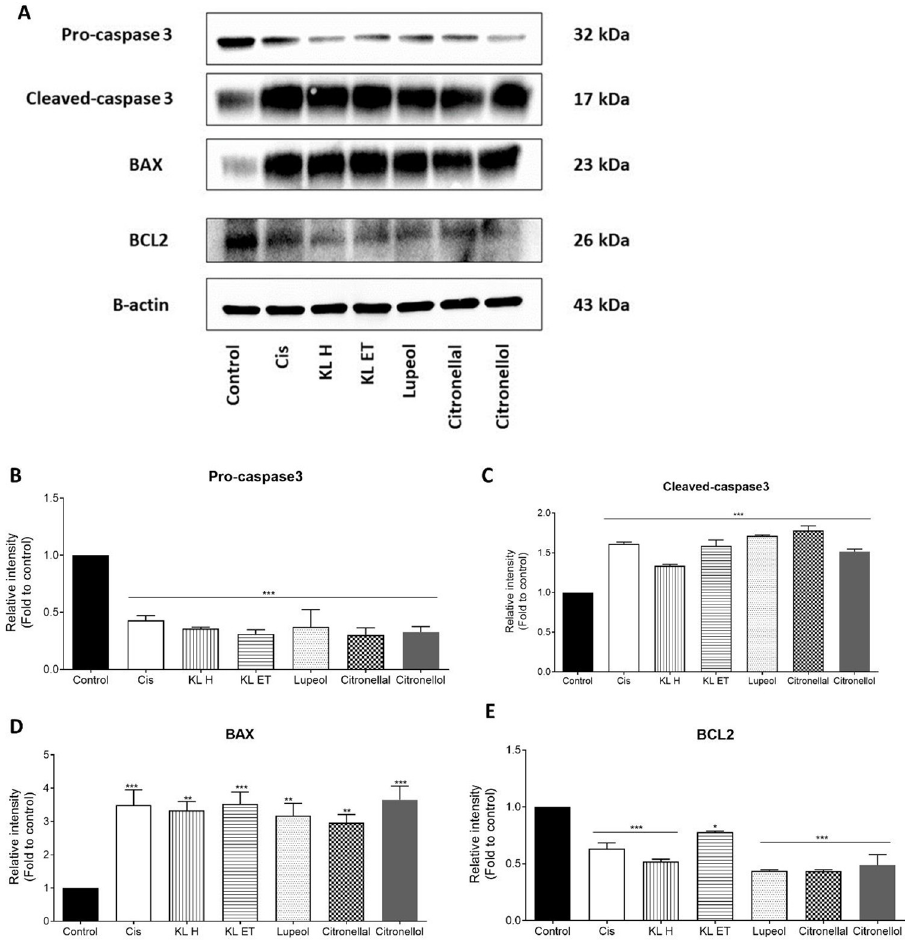
Fig 7. Western blot analysis of apoptotic proteins in SCC15 cells. (A) Band intensity of total protein levels of pro- caspase 3, cleaved-caspase 3, Bax and Bcl-2 in the control and treatment groups. (B) Relative intensity of pro-caspase 3, (C) cleaved-caspase 3, (D) Bax and (E) Bcl-2 were quantified by scanning densitometry and normalized to the control group. Bar graphs are represented as means ± SEM. � p � 0.05, �� p � 0.01 and ��� p � 0.001 compared to the control. Control: Untreated SCC15; Cis: Cisplatin; KL H: Crude hexane; KL ET: Crude ethanolic extract; Lu: Lupeol; Lal: Citronellal; Lol: Citronellol.